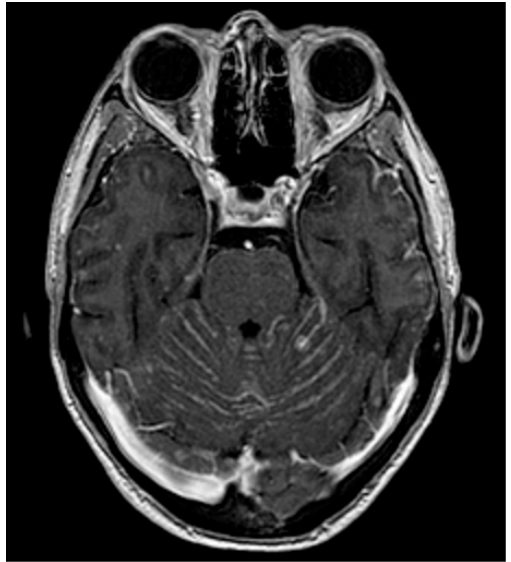
Figure 1. Cerebellar localizations of a HR-positive/HER2-negative breast cancer following CDK4/6 inhibitor